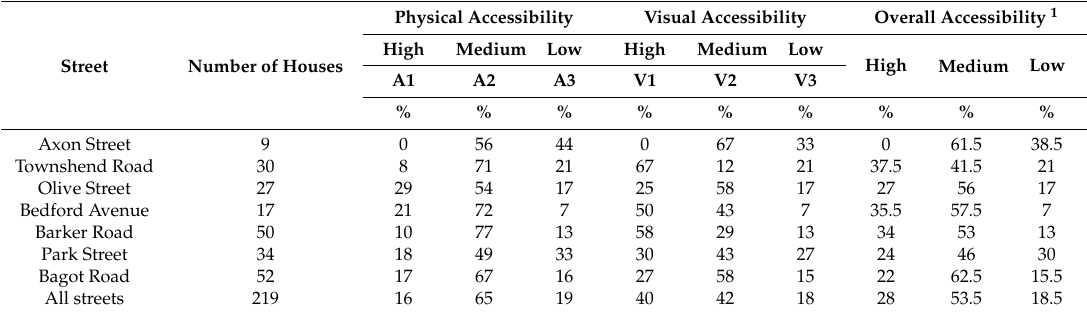
Table 4. Accessibility patterns in the analysed Subiaco